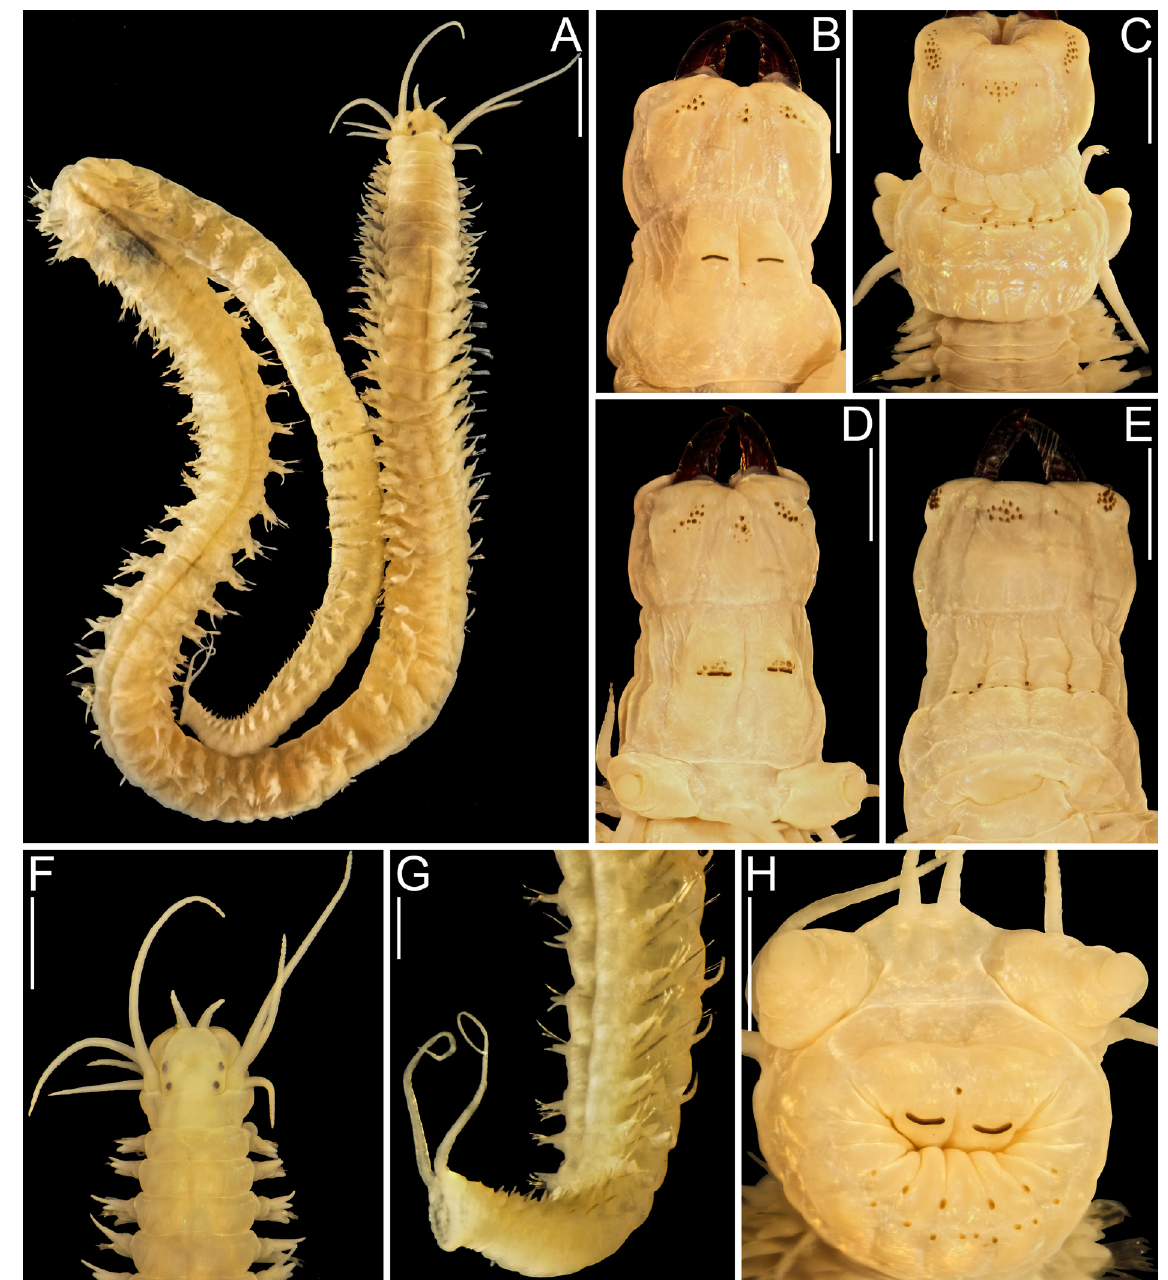
Fig. 8. Perinereis websteri sp. nov. A, F–G . Holotype (USNM 1490807). B–C, H . Paratype (USNM 1490809). D–E . Non-type (USNM 14900805). A . Whole specimen, dorsal view. B . Pharynx, dorsal view. C . Same, ventral view. D . Pharynx, dorsal view. E . Same, ventral view. F . Anterior end, dorsal view. G . Posterior end, dorsal view. H . Pharynx, ventral view. Scale bars: A = 1.5 mm; B–H = 1